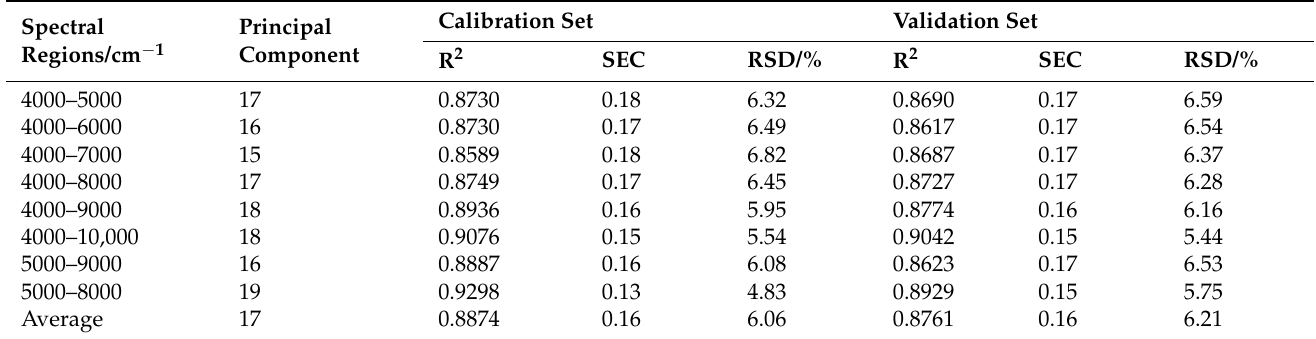
Table 3. Influence of spectral range on NIR prediction results (Tyr).